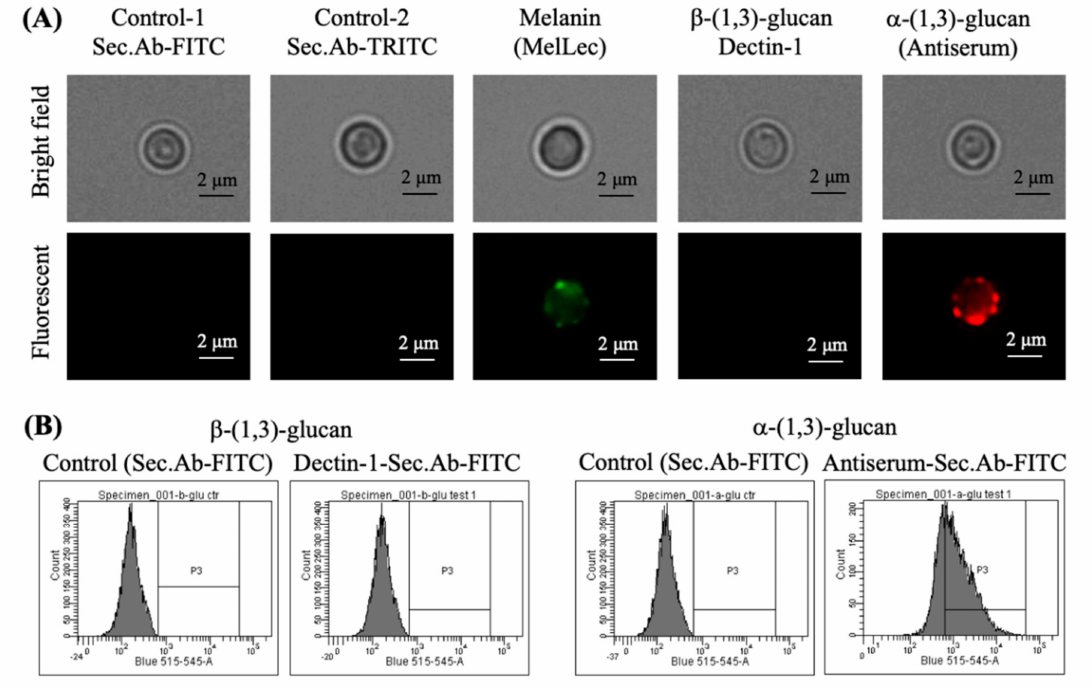
Figure 6. ( A ) Immunolabeling of parental strain conidia after the chemical removal of the rodlet layer using hydrofluoric acid (hydrofluoric acid (HF)-treated conidia); labeling was performed with MelLec, Dectin-1 (both human-Fc conjugated), and polyclonal anti- α -(1,3)-glucan-serum for melanin, β -(1,3)-glucan and α -(1,3)-glucan, respectively; controls were the HF-treated conidia incubated with secondary antibodies [anti-human-IgG-FITC for MelLec and Dectin-1 (in green), and anti-mouse-IgG-TRITC for α -(1,3)-glucan (in red)]. HF-treated conidia showed strong labeling for α -(1,3)-glucan. ( B ) Flow-cytometric analyses of HF-treated conidia labeled for β -(1,3)-glucan (with Dectin-1) and α -(1,3)-glucan (using polyclonal antiserum); controls were the HF-treated conidia incubated with secondary antibodies (Fc-specific anti-human-IgG-FITC for Dectin-1 and anti-mouse-IgG-FITC for α -(1,3)-glucan) (in the spectra shown, median fluorescence intensities for control and Dectin-1 or antiserum labeled conidia were, for β -(1,3)-glucan—148 and 147, respectively, and for α -(1,3)-glucan—145 and 899,